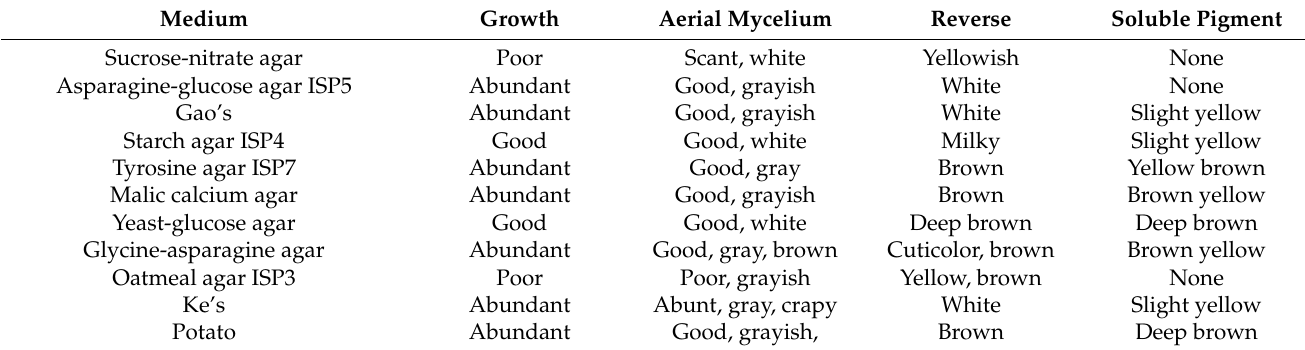
Table 1. The cultural characters of Streptomyces aureus strain